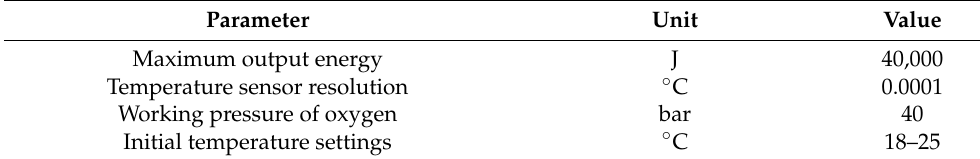
Table 3. Technical specifications of the IKA C 200 calorimeter.